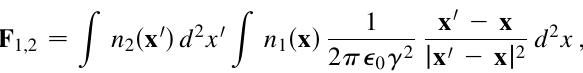
The center of the curve is shifted by half the peak value of the space charge tune shift in the 2D beam. The shape of the distribution changes noticeably as well, but for (cid:2) j & q the threshold value of the transverse resis- j Re (cid:1) n 0 tance is reduced.